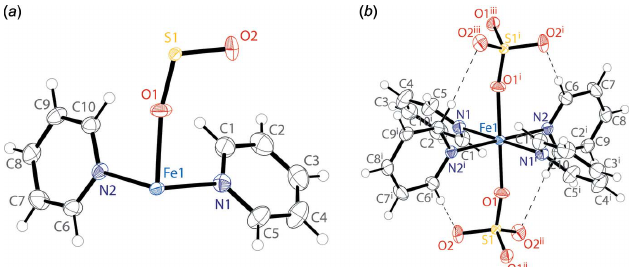
Figure 1 The molecular structure of compound ( 1 ), including ( a ) the asymmetric unit and ( b ) the coordination environment of Fe1. Displacement ellipsoids are drawn at the 50% probability level. H atoms are drawn as spheres of arbitrary radius. C—H (cid:3)(cid:3)(cid:3) O interactions (Table 1) are shown as dashed lines. [Symmetry codes: (i) (cid:5) x , (cid:5) y , (cid:5) z (ii) (cid:5) 1